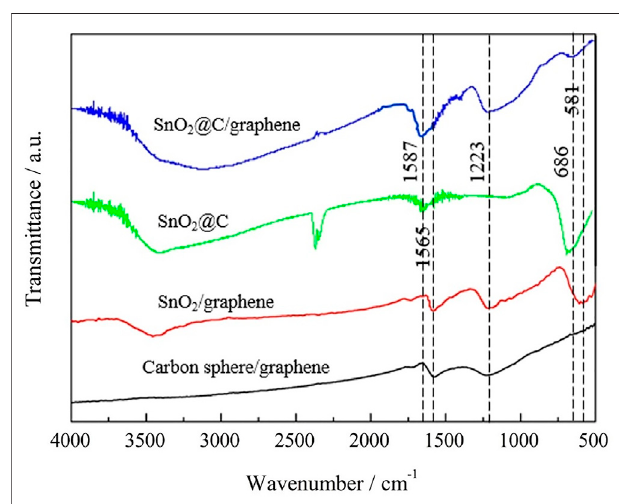
FIGURE3| FTIRspectraofcarbon spheres/graphene, SnO 2 /graphene, SnO 2 @C, and SnO 2 @C/graphene.